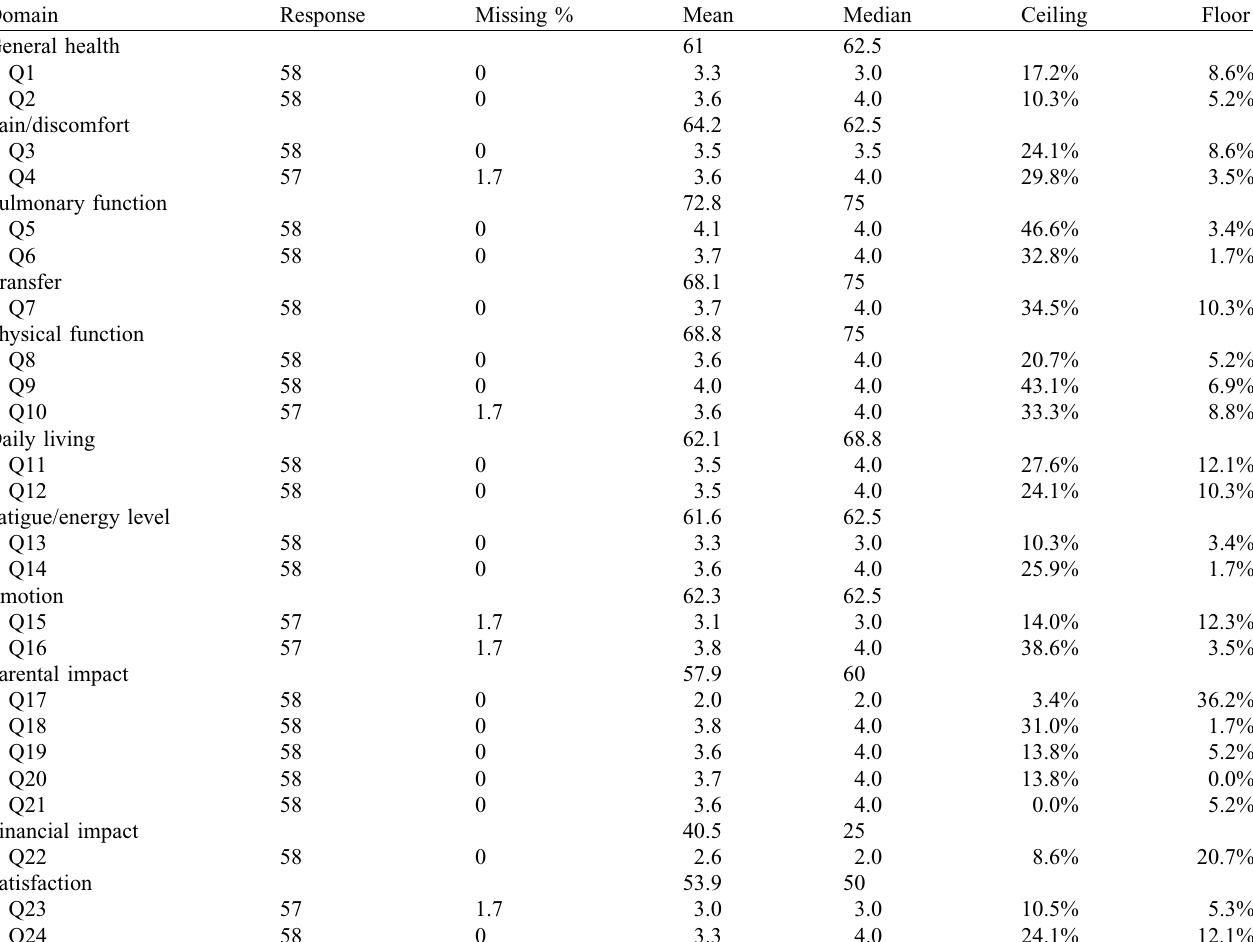
Table 3. Ceiling and fl oor effects of Arabic EOSQ-24 ( n = 58).